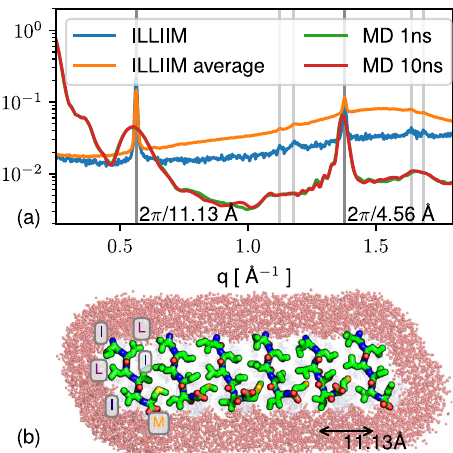
Fig. 4 Molecular dynamics simulations of the ORF6 fragment, showing a proposed molecular unit cell that corresponds to the Bragg re fl ections from the WAXS. Comparison of scattering peaks between atomistic model 2D amyloid sheet and solution SAXS/WAXS for ILLIIM. a The two major peaks (dark grey) agree well, and some agreement in second-order peaks (light grey) is also present. b The modelled 2D structures (parallel β hydrogen bonding axis goes into page) hydrophobic sidechains form a typical amyloid steric zipper. It is not proven that the solution structure is strictly 2D; however, the modelling does show that the SAXS/WAXS is consistent with an absence of full 3D symmetry in the solution. Assembly kinetics and